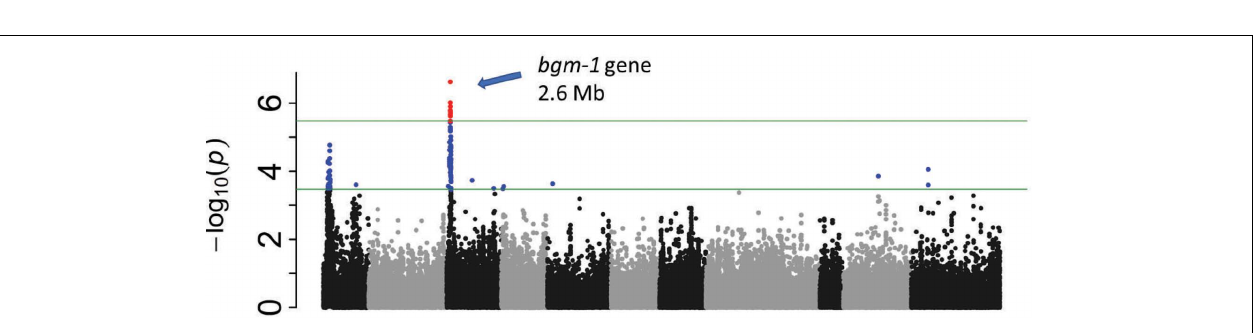
FIGURE 5 | Manhattan plot from GWAS ( Supplementary Table 3D ) in BASE_Meso evaluated (R vs. S reactions) in Honduras in 2015.